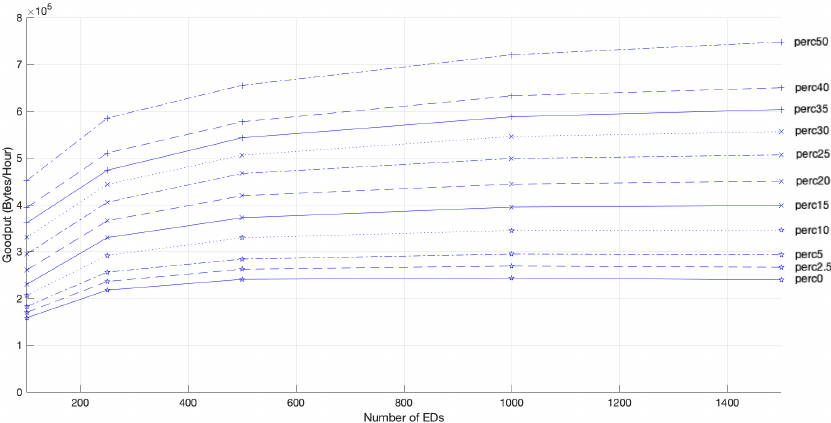
Figure 13. Network goodput for 2 GWs, different network sizes and different